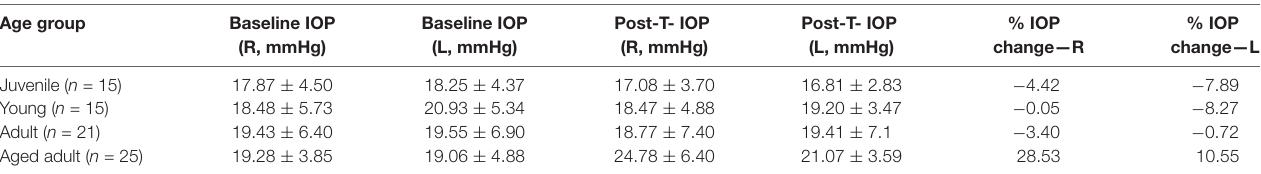
TABLE 4 | Right and left baseline intraocular pressure (IOP; mean ± SD) for each age groups expressed in